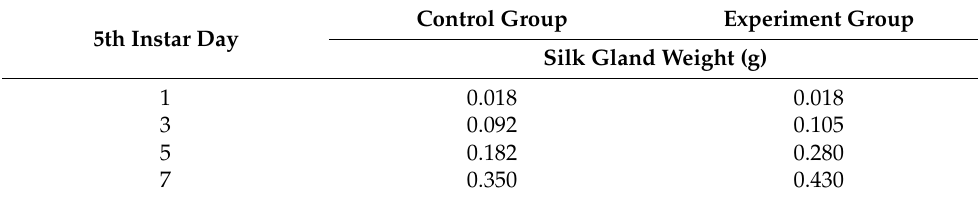
Table 2. The effect of honey-enriched diet on silk gland weight (g)